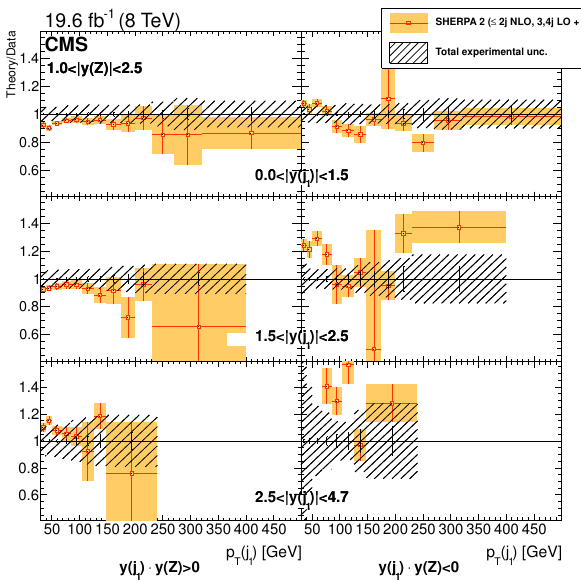
Figure 40 . Ratio to the measurement of the di(cid:11)erential cross section d 3 (cid:27)= d p T (j obtained with sherpa 2, with up to two jets at NLO and up to four jets at LO, for j y (Z) j < 1. Left column corresponds to y (j ) y (Z) > 0 and right column to y (j 1 uncertainty is shown as a band around 1. Uncertainties in the predictions are shown on the ratio points and include the statistical uncertainty only.